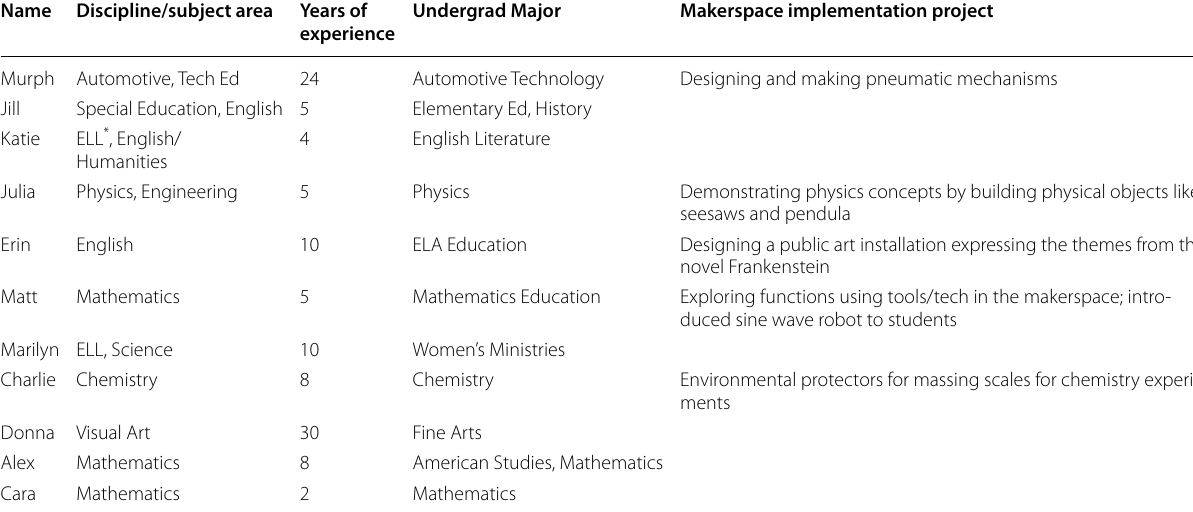
* “ELL” refers to “English language learners”, a designation used by state and district regulations, and a term used with the school to refer to both teachers and students from specific populations. We acknowledge this term conflicts with asset-oriented approaches, and agree with calls to remove it from our ways of referring to emergent bilingual and multilingual students (see González ‐ Howard & Suárez,